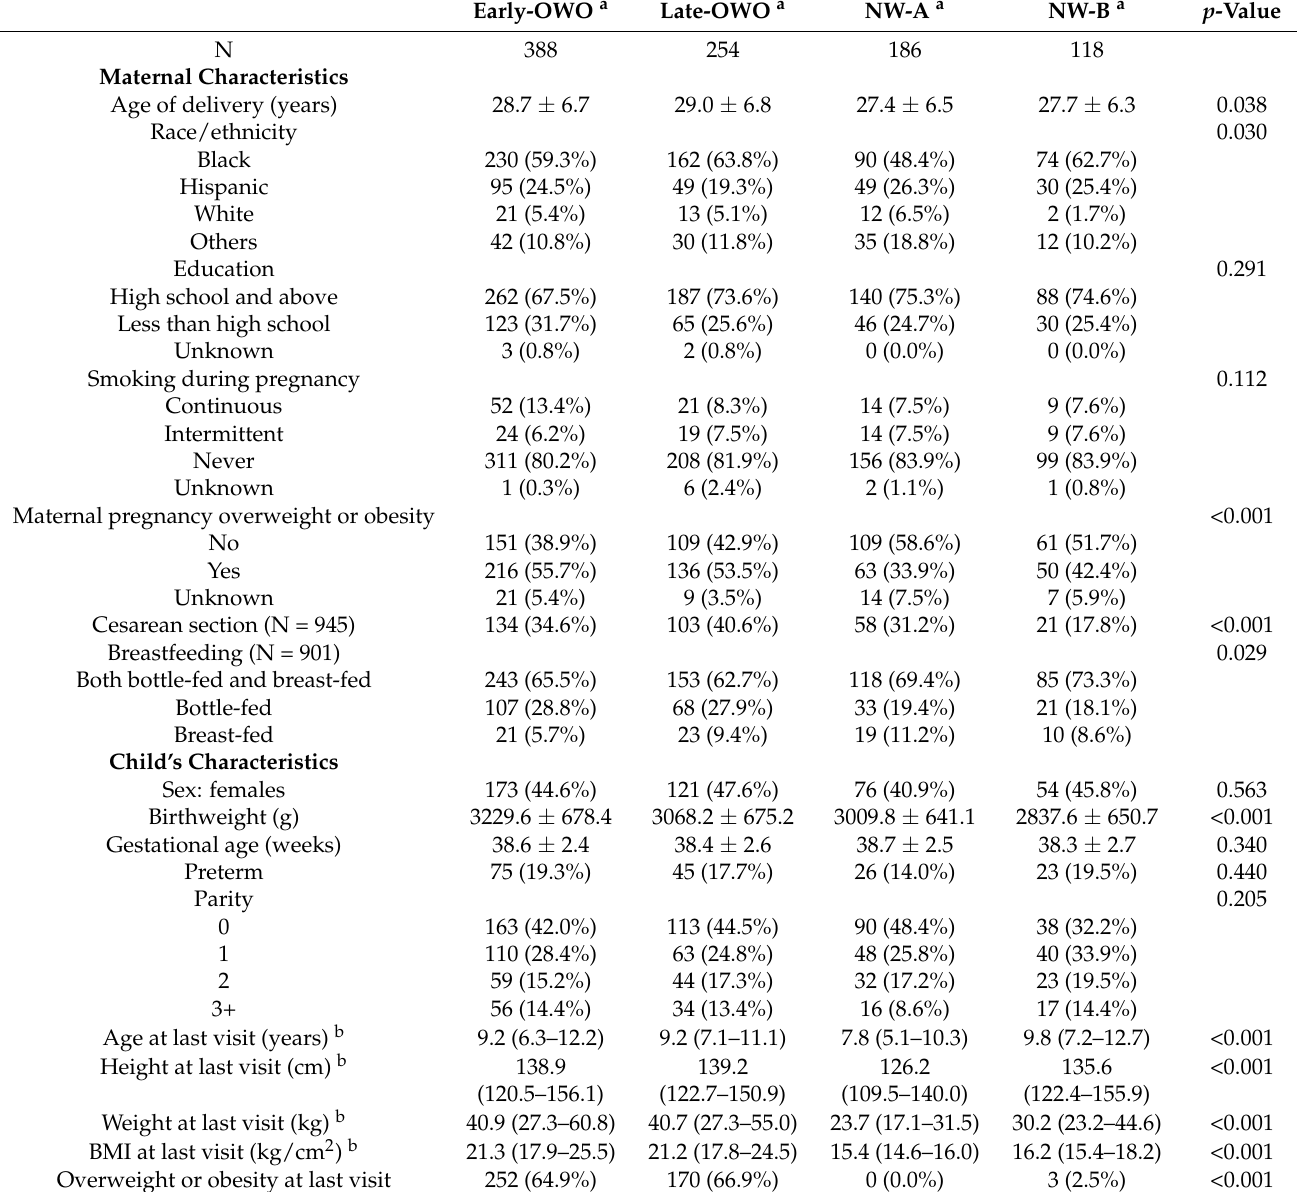
Table 1. Characteristics of mother–child pairs stratified by children’s BMI trajectory groups a